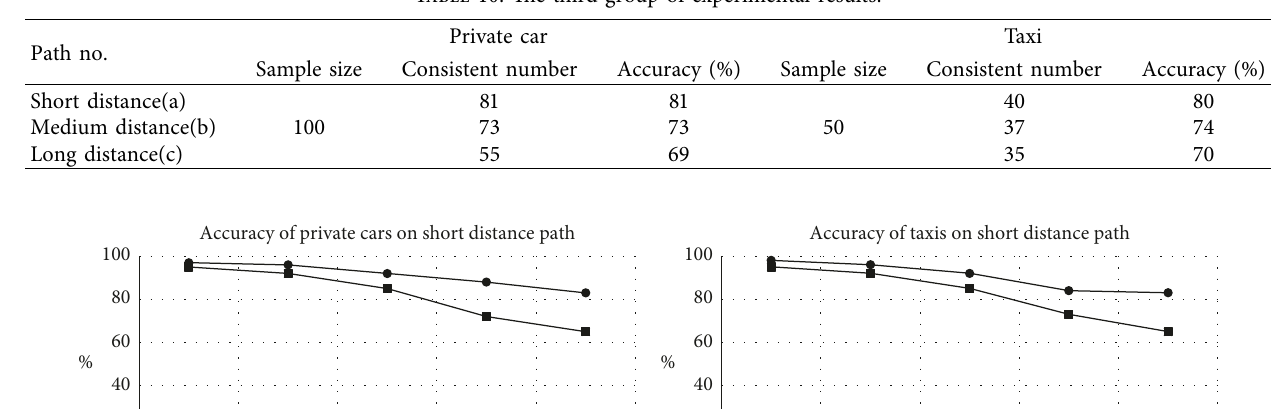
Table 10: The third group of experimental results.